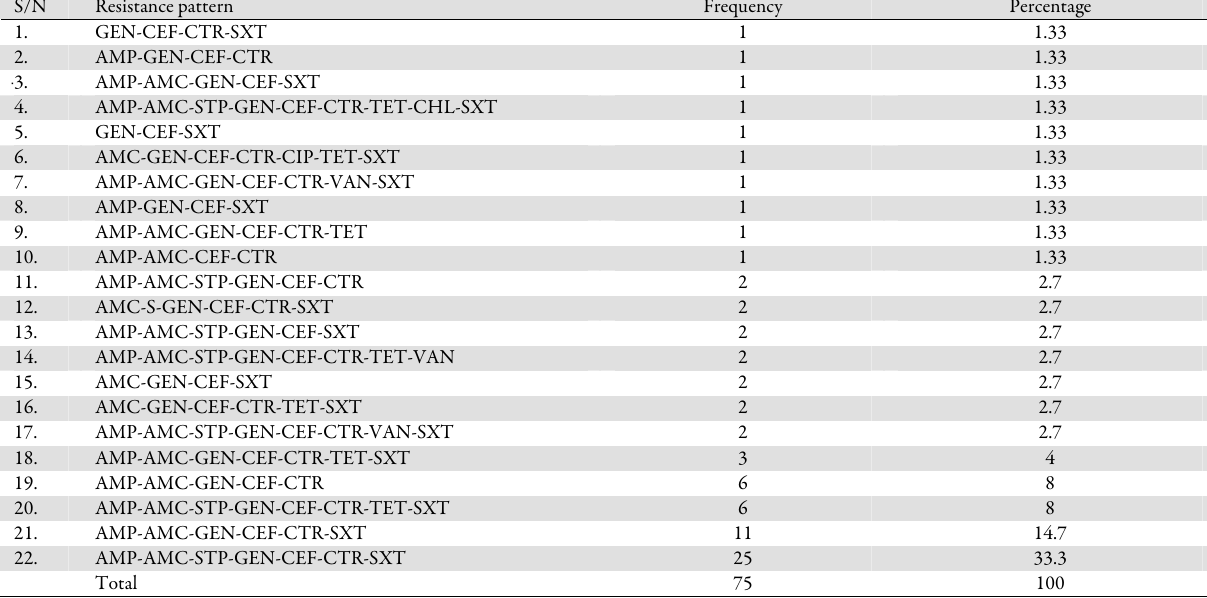
Table 1. Resistance patterns exhibited by 75 enterococcal isolates from beef